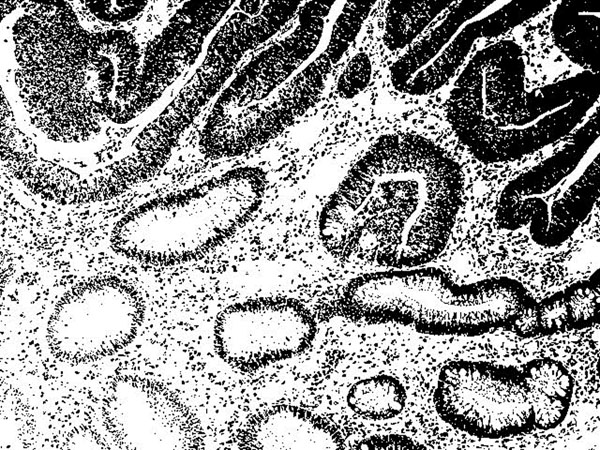
The binarized image of Figure 2.